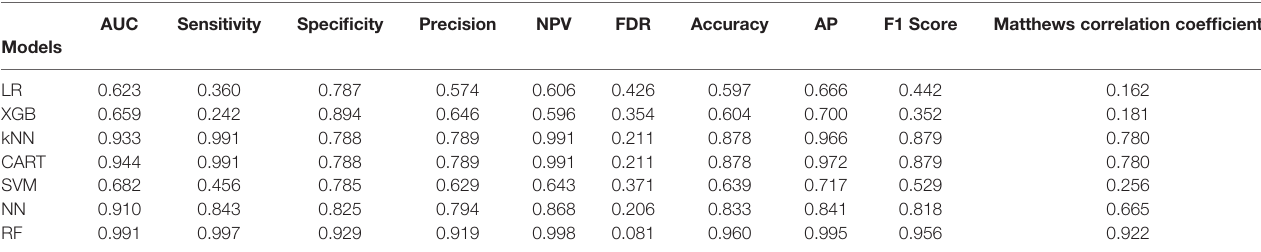
TABLE 3 | Performance of developed